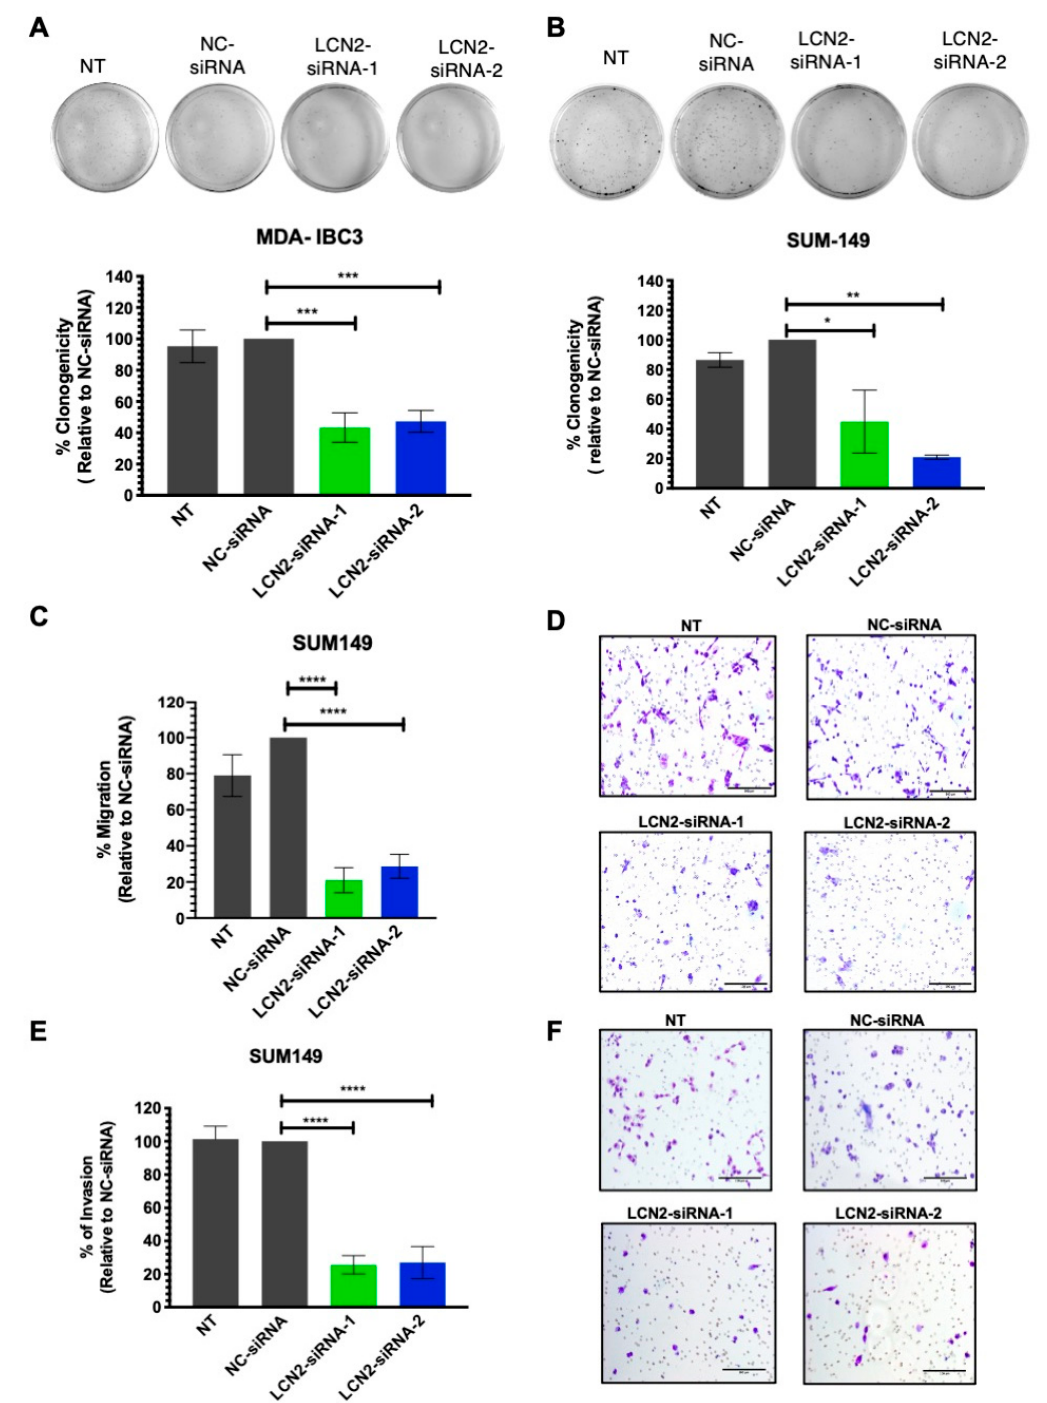
Figure 2. LCN2-siRNA-based silencing inhibits colony formation, migration, and invasion of IBC cells. Colony formation assay was performed after LCN2-siRNA-based silencing in MDA-IBC3 and SUM149 cells. Cell proliferation was performed in ( A ) MDA-IBC3 cells and ( B ) SUM149 cells. Results are shown as Mean ± SEM of triplicate experiments (* p < 0.05, ** p < 0.01, *** p < 0.001). ( C ) Migration assay was performed after LCN2-siRNA transfection (100 nM siRNA, final concentra- tion) in SUM149. ( D ) NC-siRNA cells represent 100% migration. Images of migrated cells were taken at 20 × magnification, scale bar = 100 µ m. Results are shown as Mean ± SEM of triplicate experiments (**** p < 0.0001). ( E ) Invasion assay was performed after LCN2-siRNA transfection (100 nM siRNA, final concentration) in SUM149 cells. ( F ) NC-siRNA cells repre- sent 100% invasion. Images of invaded cells were acquired with a light microscope 20 × magnification, Scale bar = 100 µ m. Results are shown as Mean ± SEM of triplicate experiments (**** p <